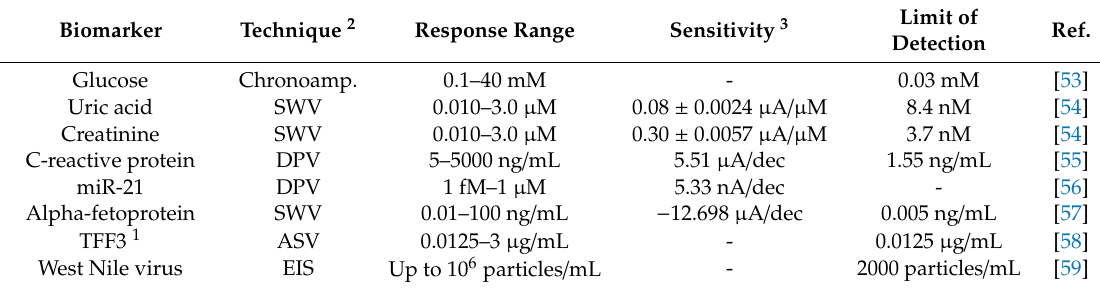
Table 3. Analytical features of the PADs with non-integrated electrochemical